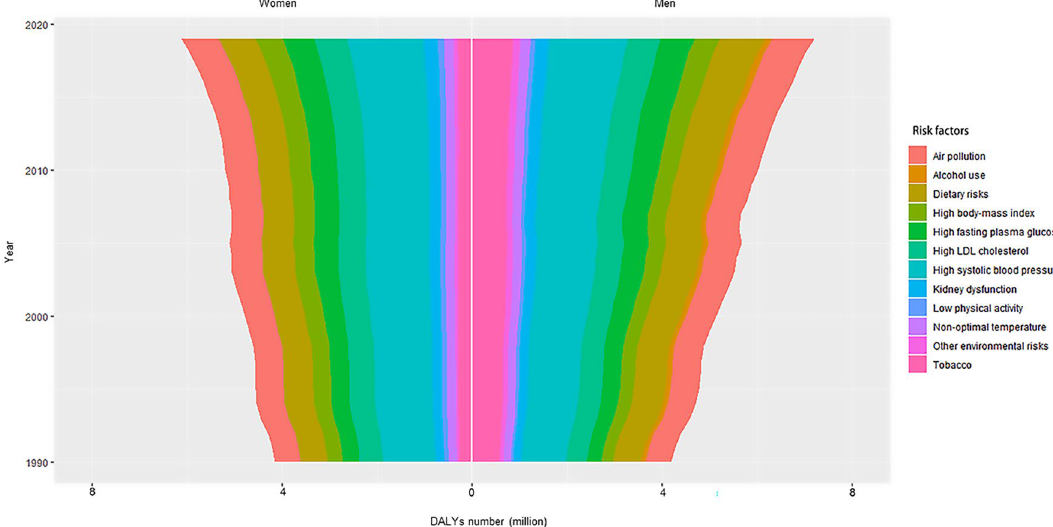
Figure 6. The sex-specific DALYs number due to ischemic stroke attributed to the twelve level 2 risk factors from 1990 to 2019. Abbreviations: DALYs, disability-adjusted life